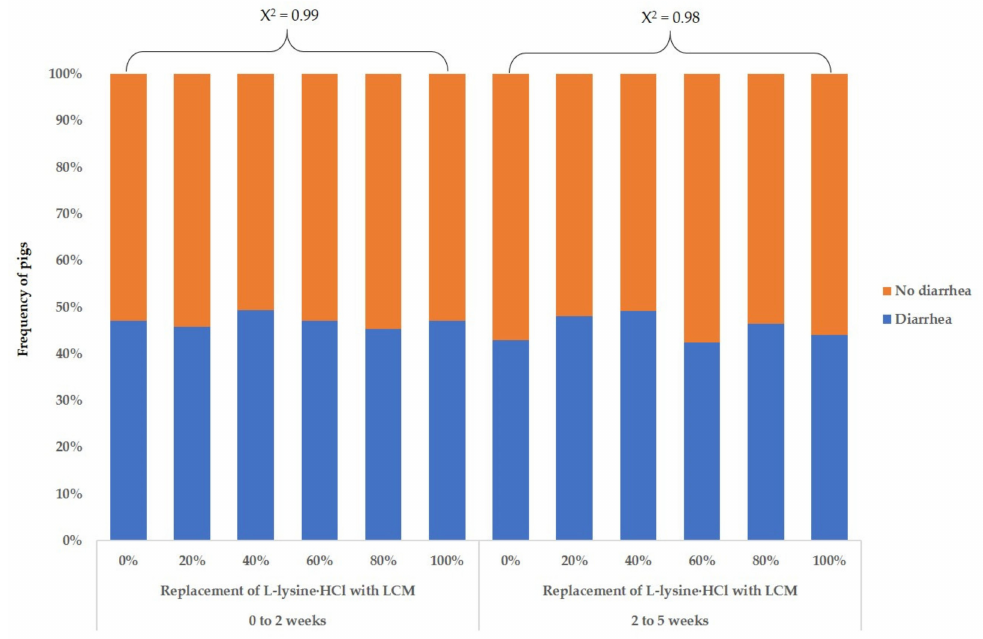
Figure 1. Effects of LCM supplementation levels on the frequency of diarrhea pigs (exp.